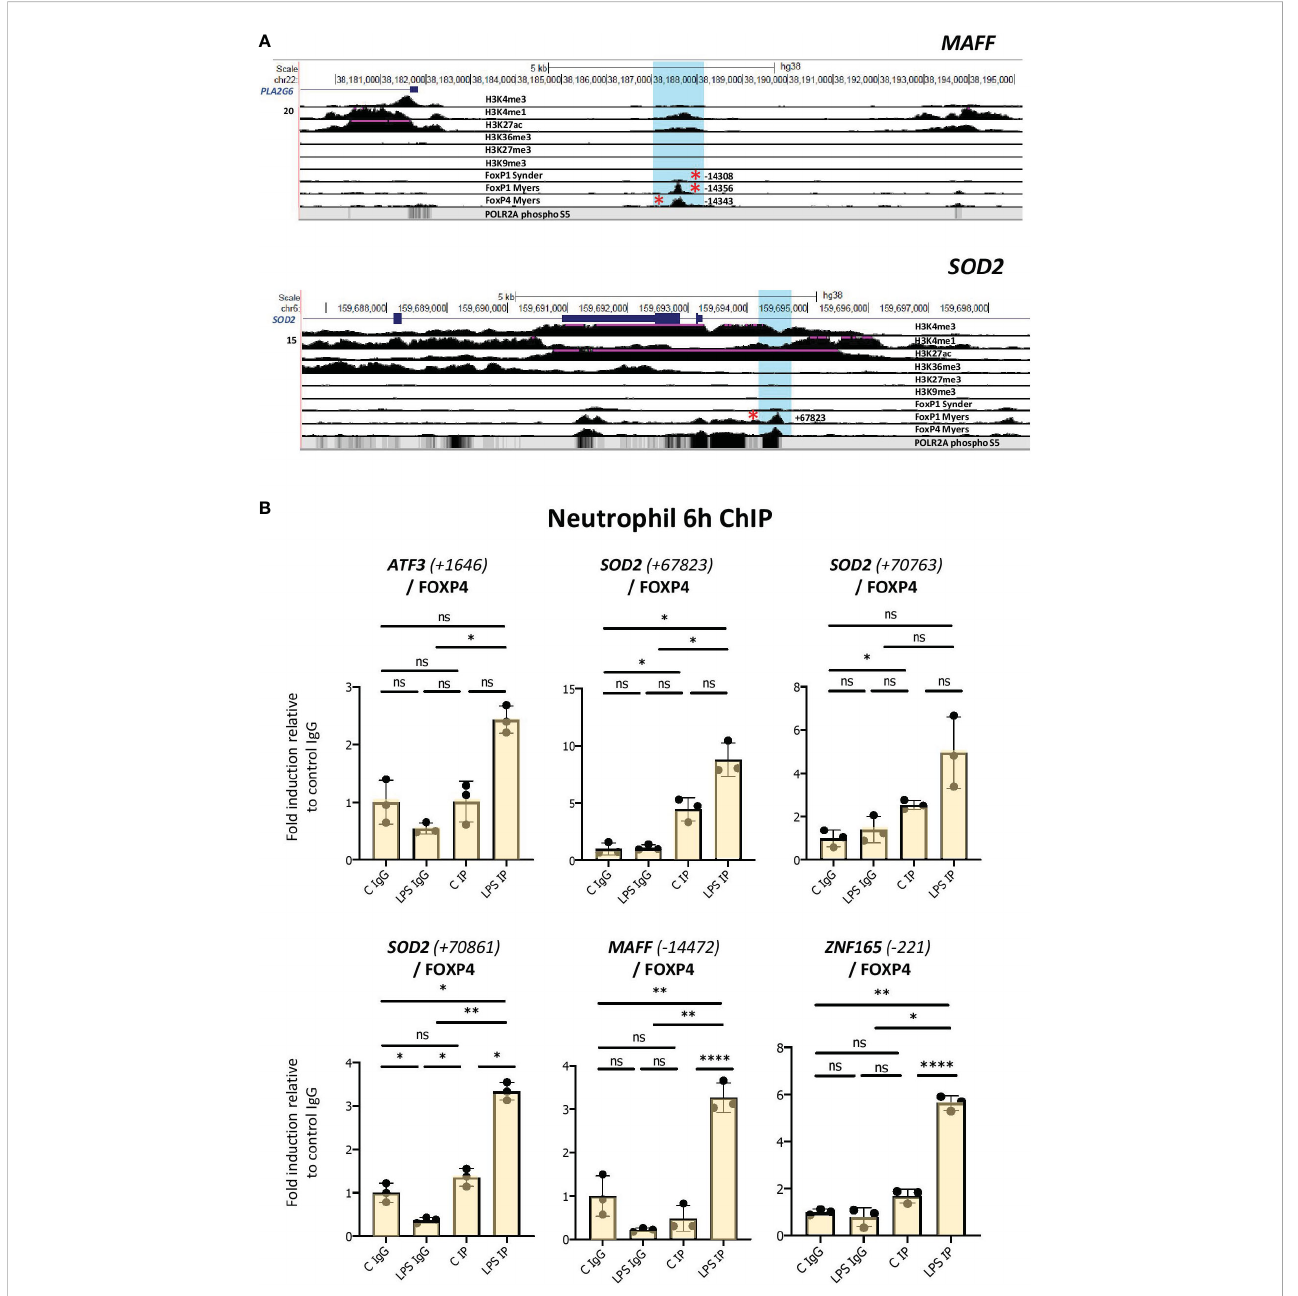
FIGURE 6 Enhanced binding of FOXP4 to network gene motifs as assessed by ChIP assay in LPS-challenged neutrophils. (A) UCSC browser images showing FOXP1 and FOXP4 ChIPseq tracks at MAFF and SOD2 loci. The areas surrounding the FOXP1/FOXP4 binding sites up and downstream (regions highlighted in blue) are shown. Red asterisks represent ChIPseq peaks that contain FOX protein motifs. Binding sites correspond to regions of enhancer function in neutrophils. (B) Analysis of the association of FOXP4 with up- and downstream regulatory regions of ATF3, SOD2, MAFF and ZNF165 by ChIP assay in neutrophils treated with or without LPS for 6h. Data representative of at least 3 biological replicates. Graphics are mean ± SD from 3 technical replicates from a representative sample. *P ≤ 0.05, **P ≤ 0.01, ****P ≤ 0.0001 and ns ≥ 0.05 as assessed by one-way ANOVAs followed by Tukey ’ s post hoc test for multiple comparisons. ChIP values are normalized to input for each condition and expressed as a fold relative to non-speci fi c IgG control. IP represents the protein-speci fi c antibody,